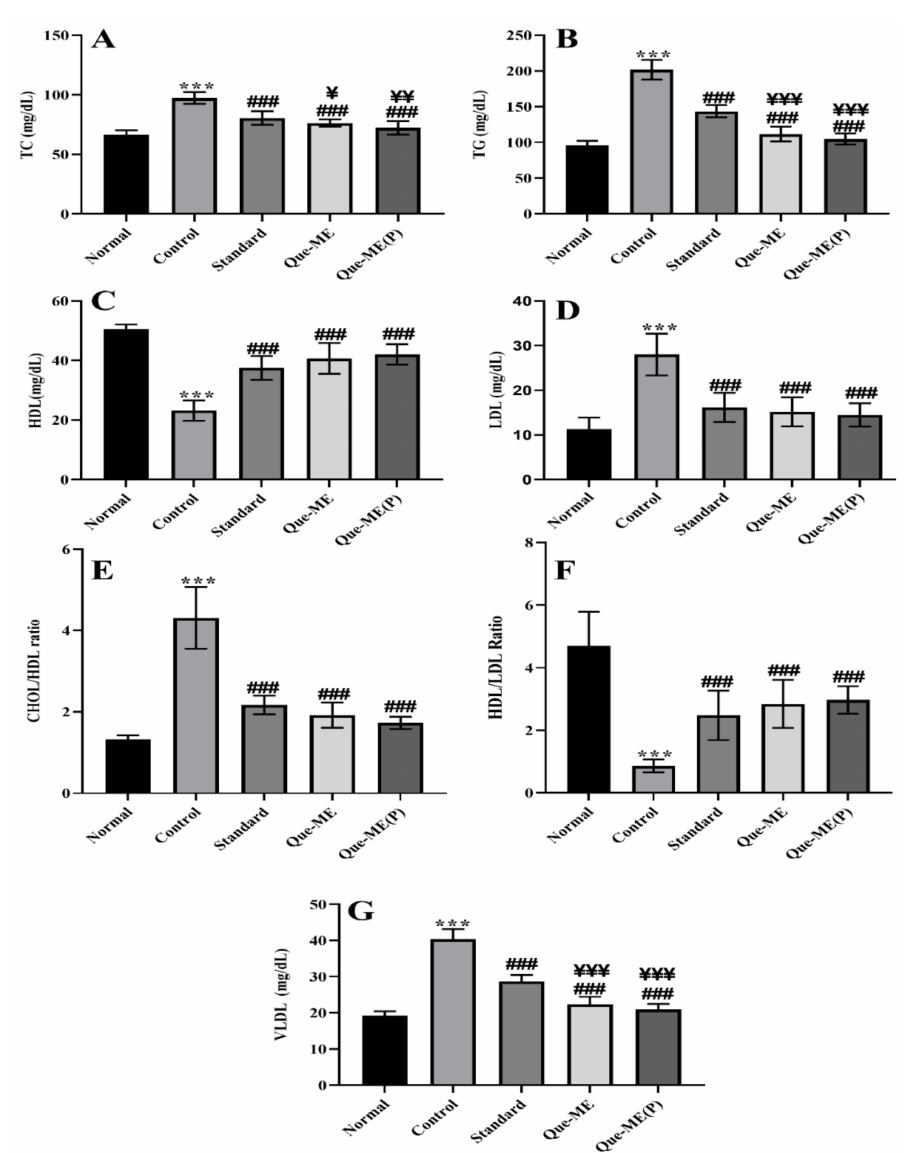
Figure 9. Effect of Que-NE and Que-NE (P) on various lipid profiles: ( A ) total cholesterol— TC; ( B ) total glycerides—TG; ( C ) high-density lipoproteins—HDL; ( D ) low-density lipoproteins— LDL; ( E ) cholesterol-to-HDL ratio—CHOL/HDL ratio; ( F ) HDL/LDL ratio; ( G ) very-low-density lipoproteins—VLDL. Data presented are the mean ± standard deviation ( n = 6). Significance was measured using one-way ANOVA. *** p < 0.001 vs. Normal group. ### p < 0.001 vs. Control group. ¥ p < 0.05, ¥¥ p < 0.01, and ¥¥¥ p < 0.001 vs. Standard group ( n =